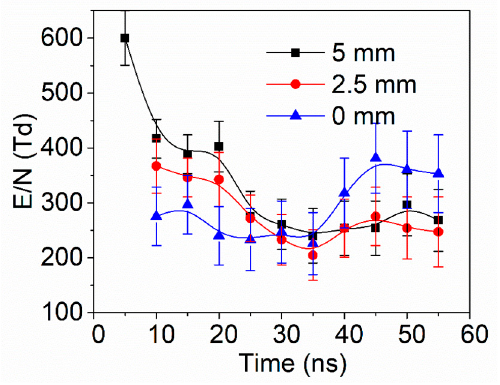
Figure 10. The temporal evolution of E/N at 0 mm, 2.5 mm, 5 mm from the plate electrode in NPDBD.